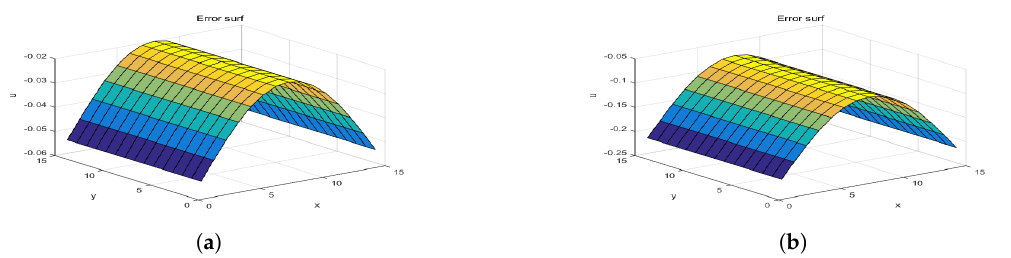
Figure 6. Example 2: For δ = 2 × 10 − 8 , z = 1: ( a ) Exact solution, and ( b ) approximation solution.